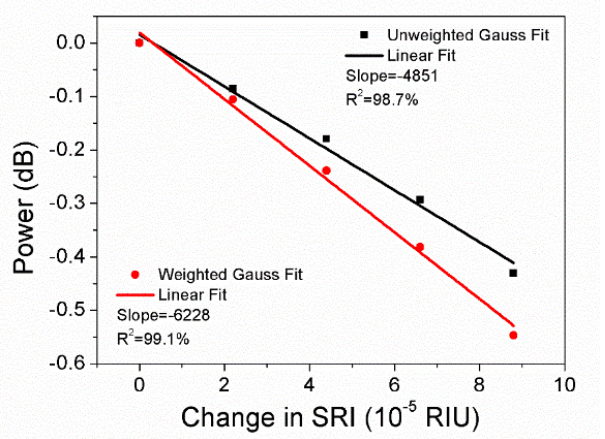
Figure 12. Linear regression of the cladding mode amplitude obtained by 5-data unweighted and weighted Gauss fitting in terms of SRI change 8.8 × 10 − 5 for the wavelength resolution 0.14 nm.